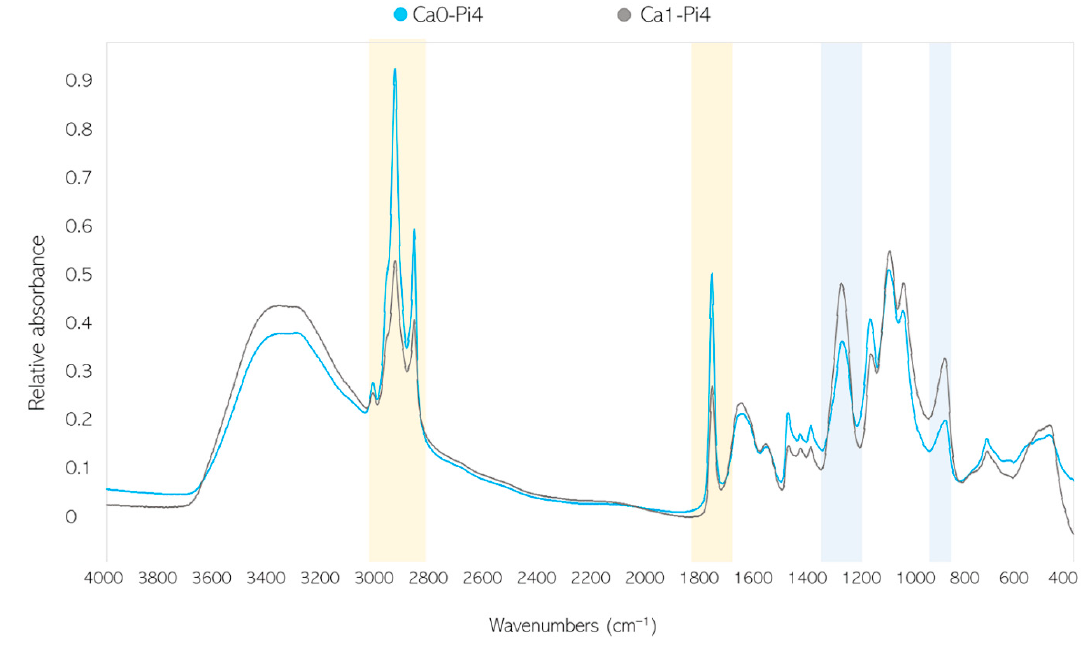
Figure 3. Fourier-transform infrared spectroscopy–high-throughput screening (FTIR-HTS) spectra of Mucor circinelloides VI 04473 biomass produced in Ca0-Pi4 (blue) and Ca1-Pi4 (grey) media. The main, characteristic lipid-related peaks are highlighted in yellow, while the polyphosphate-related spectral regions are highlighted in blue.